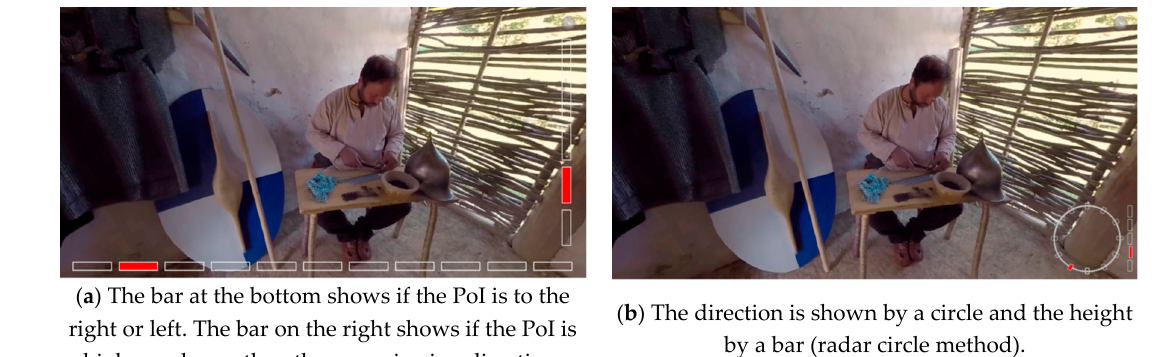
Figure 1. Two overlay methods for CVR (Images taken from our work).